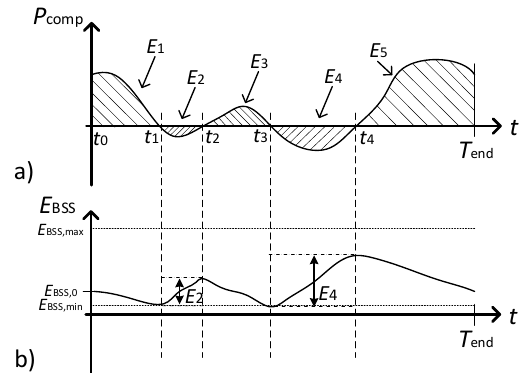
Fig. 4. Example for compensation power and the related stored energy of the